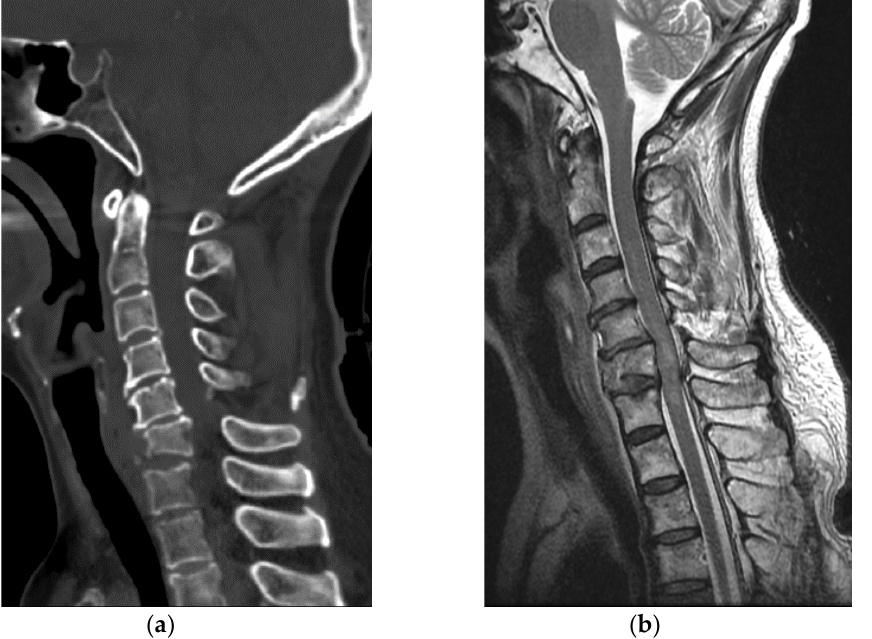
Figure 5. ( a ) Cervical spine CT showed C5-C6 dislocation with C6 vertebral body compression fracture; ( b ) Cervical spine MRI revealed flexion-distraction with translation injury at C5-C6, cord contusion with an intramedullary hemorrhage and complete DLC disruption. contusion with an intramedullary hemorrhage and complete DLC